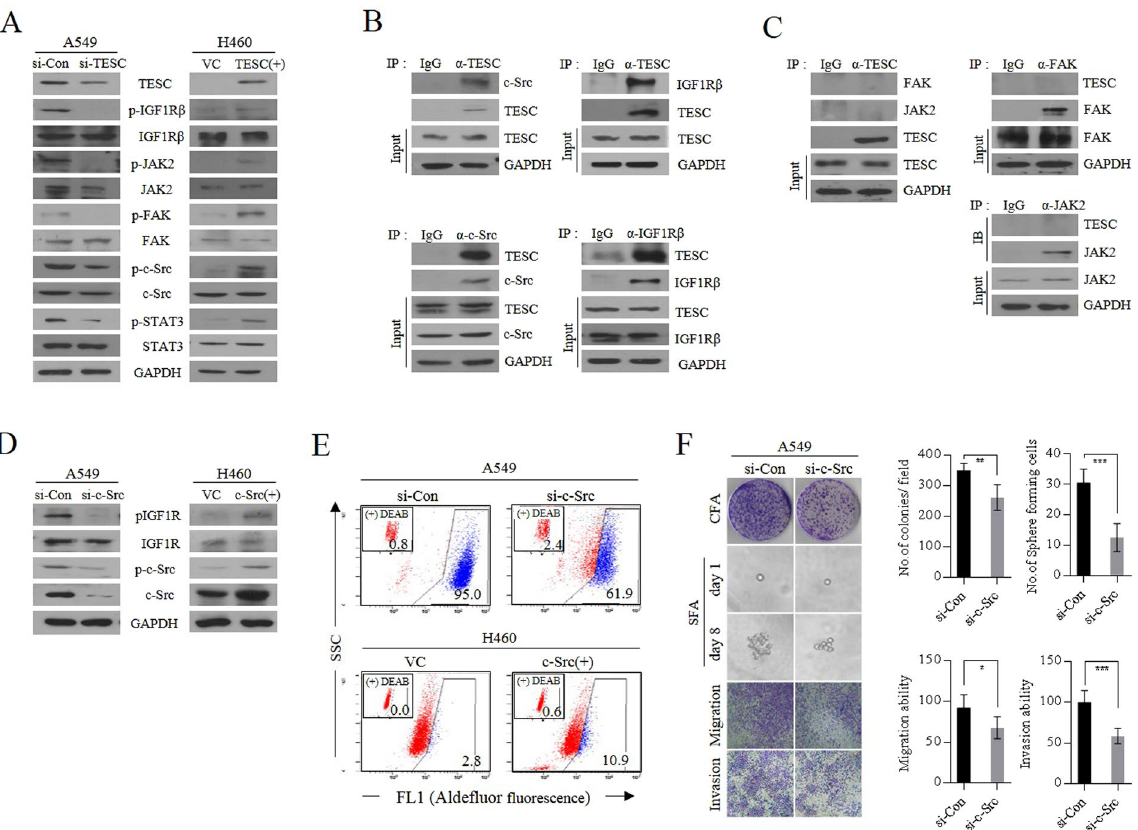
Figure 4. TESC mediates the activation of the IGF1R/c-Src/STAT3 signaling pathway. ( A ) The activation of c-Src, FAK, and STAT3 was assayed using western blot analysis in A549 cells transfected with the siRNA and H460 cells transfected with TESC -pcDNA3.1 vector. ( B ) The interactions between TESC, c-Src and IGF1R β were determined by immunoprecipitation assays in A549 cells. ( C ) The interactions between TESC, JAK2 and FAK were evaluated by immunoprecipitation assays in A549 cells. ( D ) Phosphorylation levels of IGF1R β in c - Src knockdown A549 cells and c - Src -overexpressing H460 cells. ( E ) Fluorescence-activated cell sorting (FACS) analysis of ALDH1 in c - Src knockdown A549 cells and c - Src -overexpressing H460 cells was performed using ALDEFLUOR assay. ( F ) Colony forming, sphere forming and metastatic analysis in c - Src knockdown A549 cells. Data represent mean ± SD of three independent experiments using two-tailed t-test. * P < 0.05, ** P < 0.01, *** P <